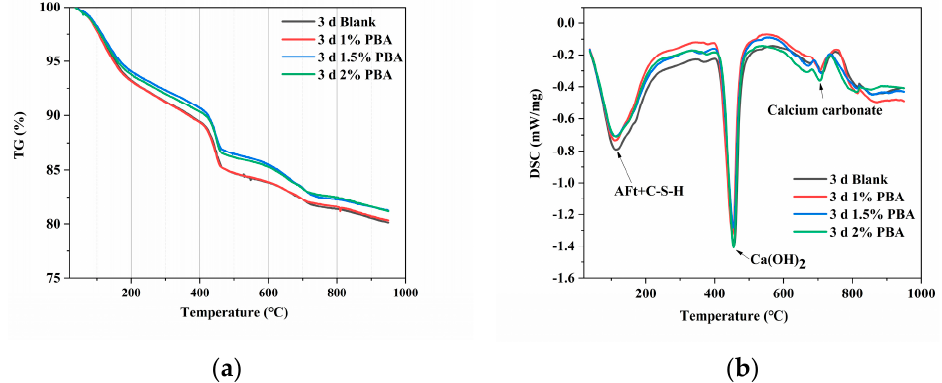
Figure 7. TG - DSC curves of cement slurries with di ff erent PBA contents at three days. (a) TG curve Figure 7. TG-DSC curves of cement slurries with different PBA contents at three days. ( a ) TG curve and (b) DSC curve. and ( b ) DSC